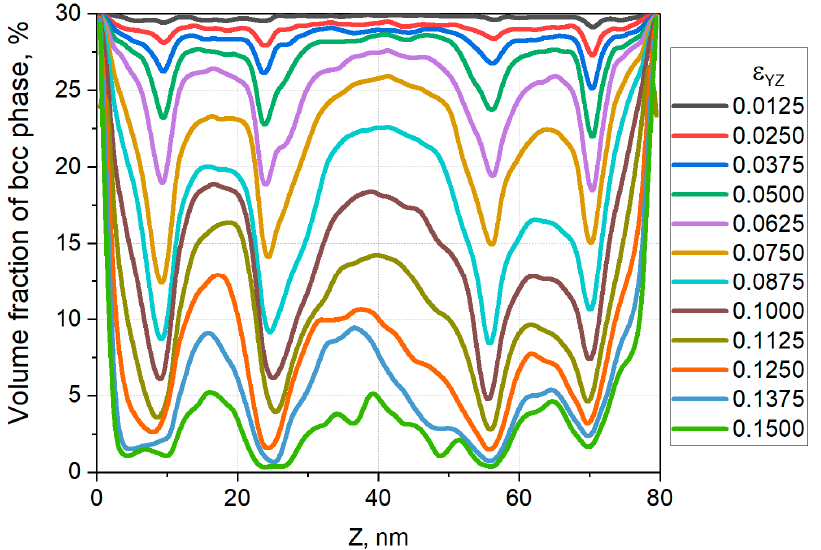
Figure 14. Z-axial distribution of the volume fraction of the bcc phase for different compressive strains of the bcc30_L1 sample.